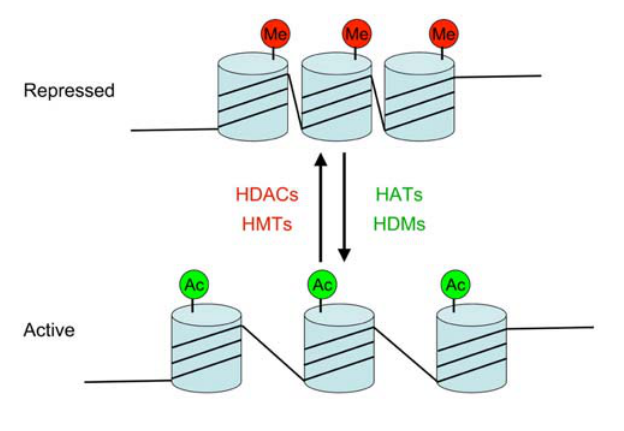
FIGURE 2 . Transitions from repressed to active chromatin and vice versa are regulated by a balance of active chromatin marks (e.g., histone H3-K9 acetylation, shown as green circles) and repressive marks (e.g., histone H3-K27 methylation, shown as red circles). Enzymes that add or remove these marks control the balance between active and repressed chromatin. For example, histone acetyltransferases (HATs) and histone demethlyases (HDMs) generally function to promote active chromatin, while histone deacetylases (HDACs) and histone methyltransferases (HMTs) promote inactive